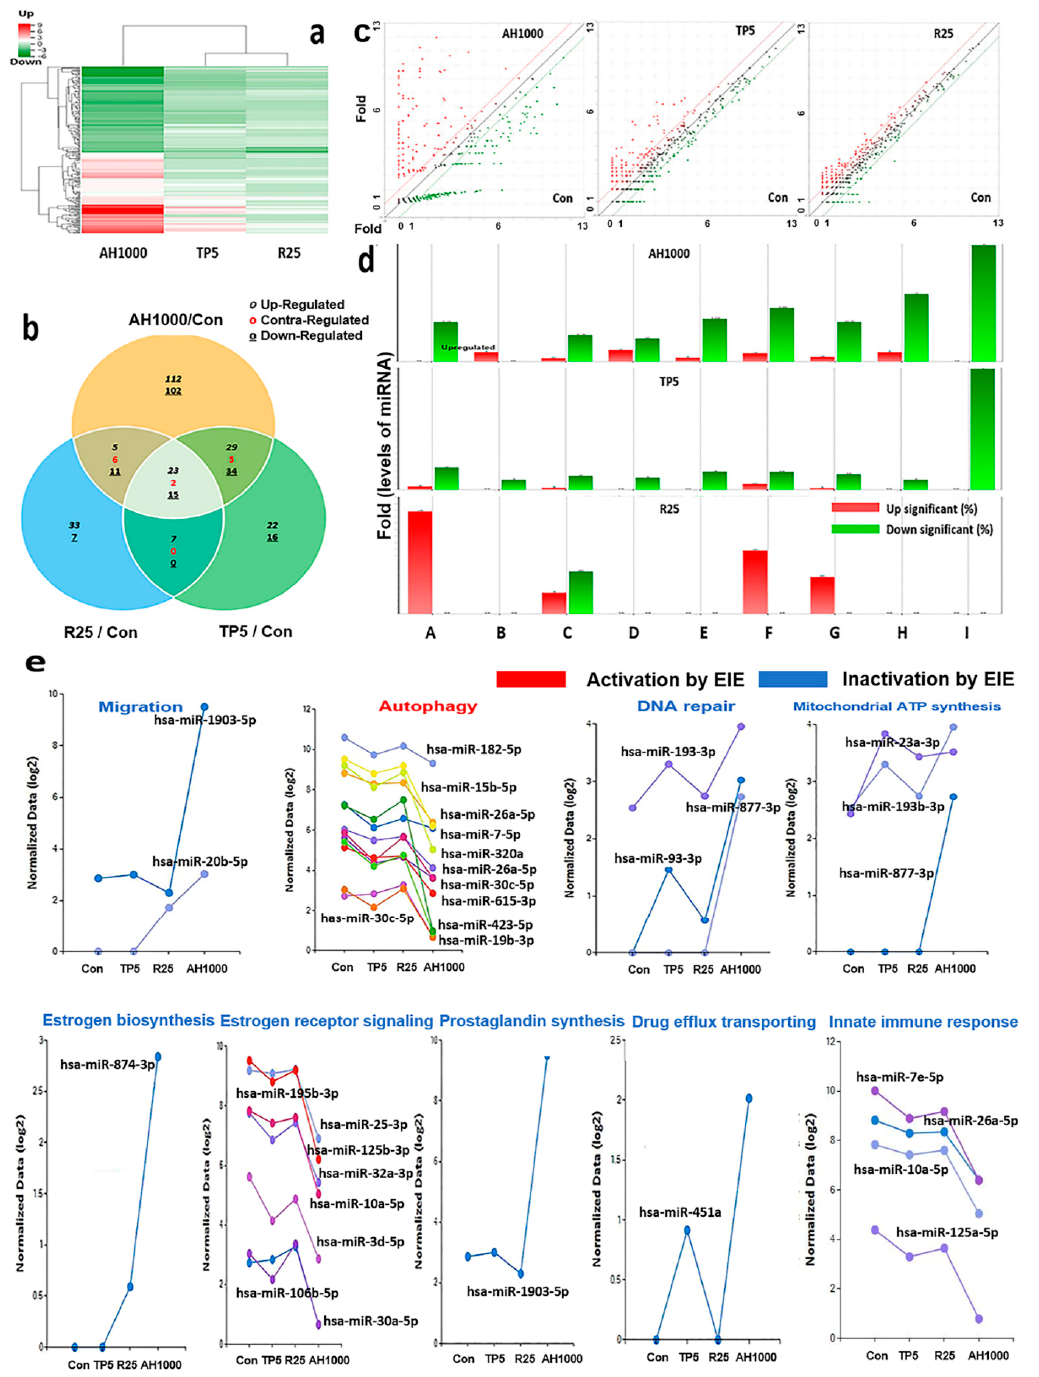
Figure 5. Profiling of miRNAs in the induced exosomes from endometrial cancer (EC) cells; ( a ) The heatmap for microRNA in exosomes induced by the three substances. ( b ) The Venn diagram for microRNAs in EC cells in the presence of three substances. ( c ) The scattering plots of the control and bioactive substances. ( d ) The microRNAs involved in several categories (A: positive regulation of autophagy, B: drug transmembrane transport, C: positive regulation of cell migration involved in sprouting angiogenesis, D: estrogen biosynthetic process, E: positive regulation of prostaglandin biosynthetic process, F: mitochondrial ATP synthesis coupled proton transport, G: positive regulation of DNA repair and regulation of innate immune response, H: negative regulation of intracellular estrogen receptor signaling pathway, I: positive regulation of DNA repair. ( e ) The biological classification of significant microRNAs in the induced exosomes; 5 µ g/mL tocopherol- α (TP5), 25 µ g/mL rutin (R25), and 1000 µ g/mL A. helianthus extract (AH1000). 2 times ≤ fold changes and 0.5 times ≥ fold changes; * p < 0.05; ** p < 0.01; *** p <